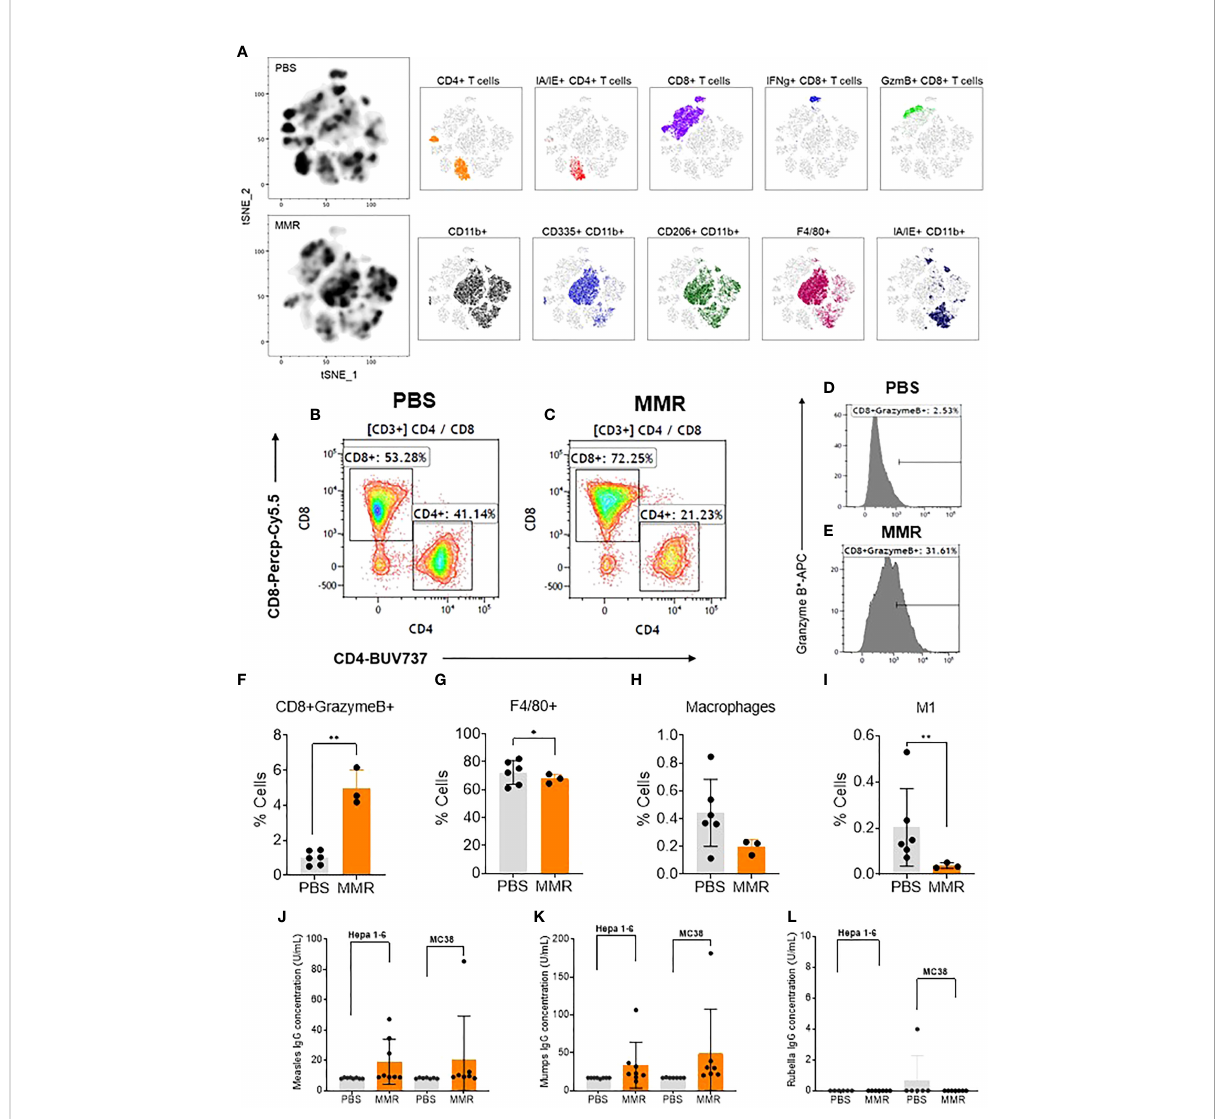
FIGURE 2 Analysis of tumor-in fi ltrating immune cells following intratumoral injection of MMR vaccine. (A) T-distributed stochastic neighbor embedding (tSNE) analysis showed a relatively dense intratumoral population of murine immune cells in Hepa 1-6 tumors treated with MMR vaccine compared to controls (PBS). We performed the tSNE plot on 10,000 downsampled events from viable CD45+ population per sample. The submyeloid population representing macrophages are CD11b+F480+ cells, and the two markers used to segregate the M1 and M2 sub- populations are CD206 and I-A/I-E, known as major histocompatibility class II (MHCII) in mouse. An example of gating shows two subpopulations based on their CD8+ and CD4+ T-cells frequencies between tumors treated with PBS (B) or MMR (C) . Histograms illustrating the increased frequency of tumor-in fi ltrating CD8+ granzyme B+ reactive CTLs in MMR compared to PBS (D, E) . Graphs showing the signi fi cant increase in CD8+ granzyme B+ (F) and reduction of F4/80+ macrophages (G) , total macrophages (H) , and in fl ammatory M1 macrophages (I) in the MMR group compared to PBS. The Bartlett test was used to test homogeneity of variance and normality. If the p value of the Bartlett test was no less than p=0.05, ANOVA and a two-sample t test were used to compare group means. If the p value of the Bartlett test was less than 0.05, the KruskalWallis and Wilcoxon rank-sum tests were used to compare group means. The fi gures demonstrate the potential signi fi cant difference of the gated subsets in the CD45+ population, determined by the p value. Quanti fi cation of virus-speci fi c Immunoglobulin in serum. Blood was processed to serum to measure the levels of speci fi c immunoglobulin (IgG) to measles (J) (negative < 8 U/mL positive > 10 U/mL), mumps measles (K) (negative < 17 IU/mL positive > 20 IU/mL), and rubella measles (L) (negative < 10 IU/mL equivocal 10-15 IU/mL positive > 15 IU/mL) in the MMR vs. PBS treated group. *P=0.03,